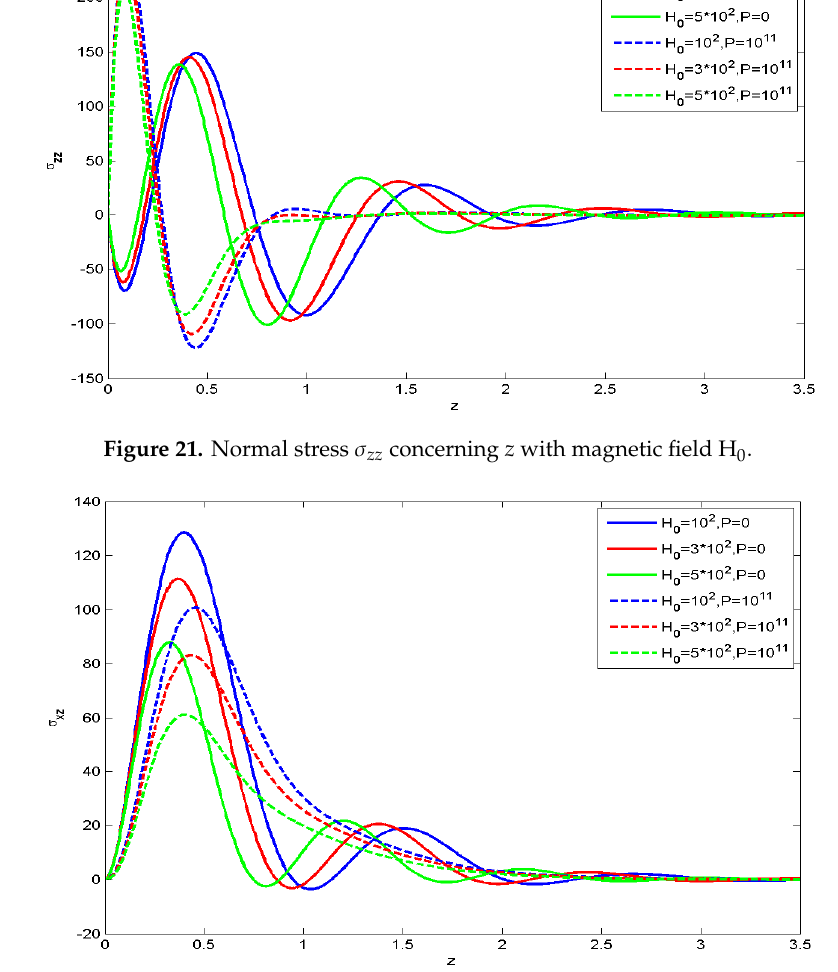
Figure 22. Shear stress σ xz concerning z with magnetic field H 0 .